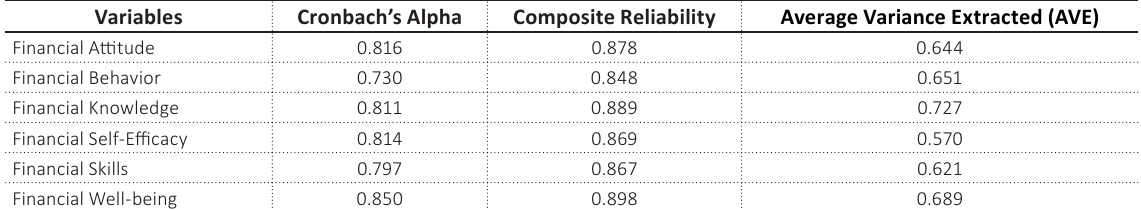
Table 4. The result of the second PLS-SEM algorithm